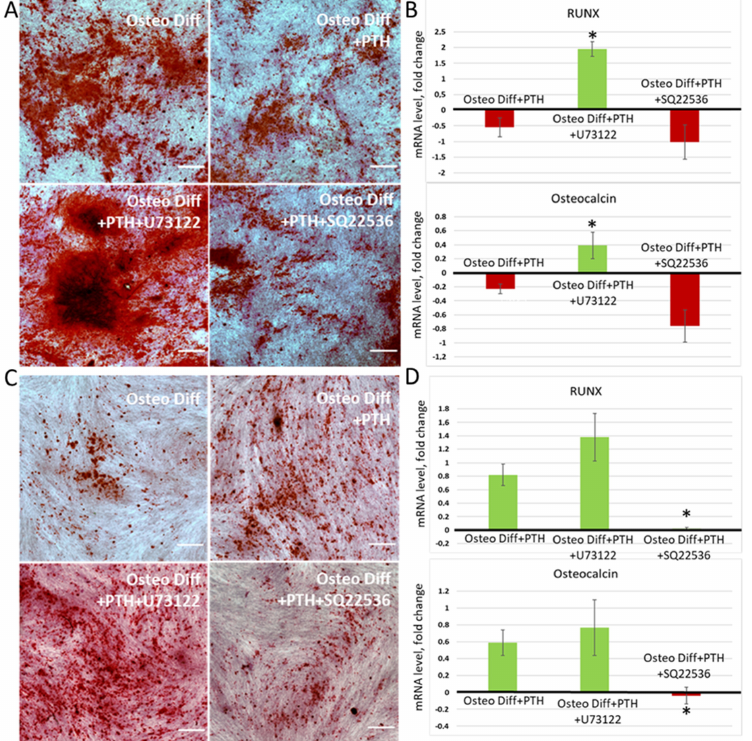
Figure 6. PLC (U73122) and AC (SQ22536) inhibitors modulate the effect of PTH on MSC osteogenic differentiation. All presented pictures of histochemical staining were obtained on the cells from dif- ferent MSC depots of the same donor ( A , B ) Differentiation of MSC from periosteum in presence of PTH and inhibitors of PTH1R-related secondary messenger systems. ( A ) Histochemical staining of calcium deposits with Alizarin red. The scale bar represents 500 µm. ( B ) Expression of osteogenic markers in MSC from periosteum on 14th day of osteogenesis. Mean ± SE, n = 4 different donors; * p < 0.05 versus values in “osteogenic differentiation + PTH” group. ( C , D ) Differentiation of MSC from adipose tissue in presence of PTH and inhibitors of PTH1R-related secondary messenger sys- tems. ( C ) Histochemical staining of calcium deposits with Alizarin red. The scale bar represents 500 µm. ( D ) Expression of osteogenic markers in MSC from adipose tissue on 14th day of osteogenesis. Mean ± SE, n = 4 different donors; * p < 0.05 versus values in “osteogenic differentiation + PTH” group.